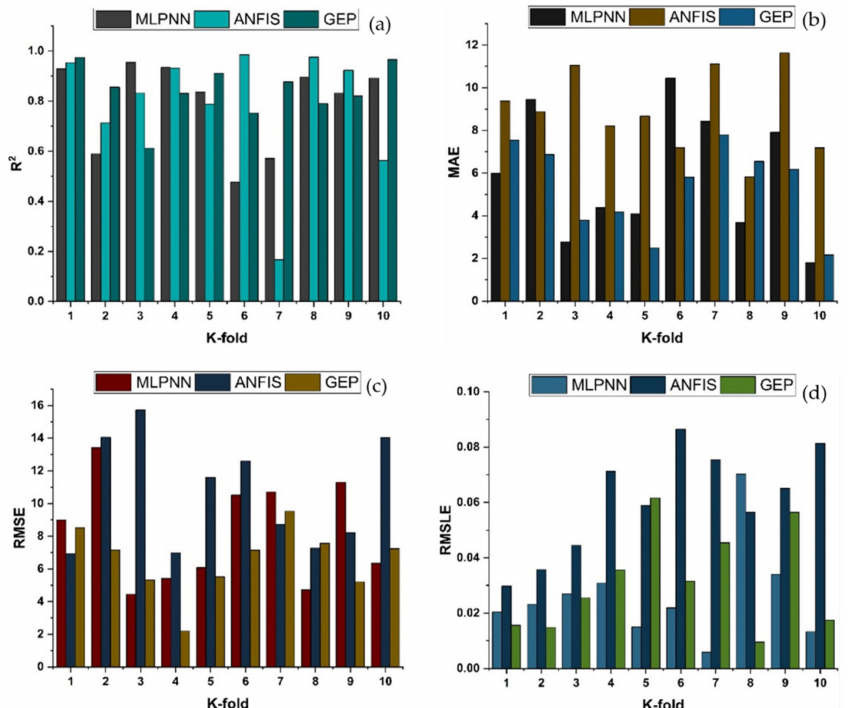
Figure 16. K-fold cross validation of compressive strength for MLPNN, ANFIS and GEP; ( a ) Based on R 2 ; ( b ) Based on MAE; ( c ) based on RMSE; ( d ) based on RMSLE.